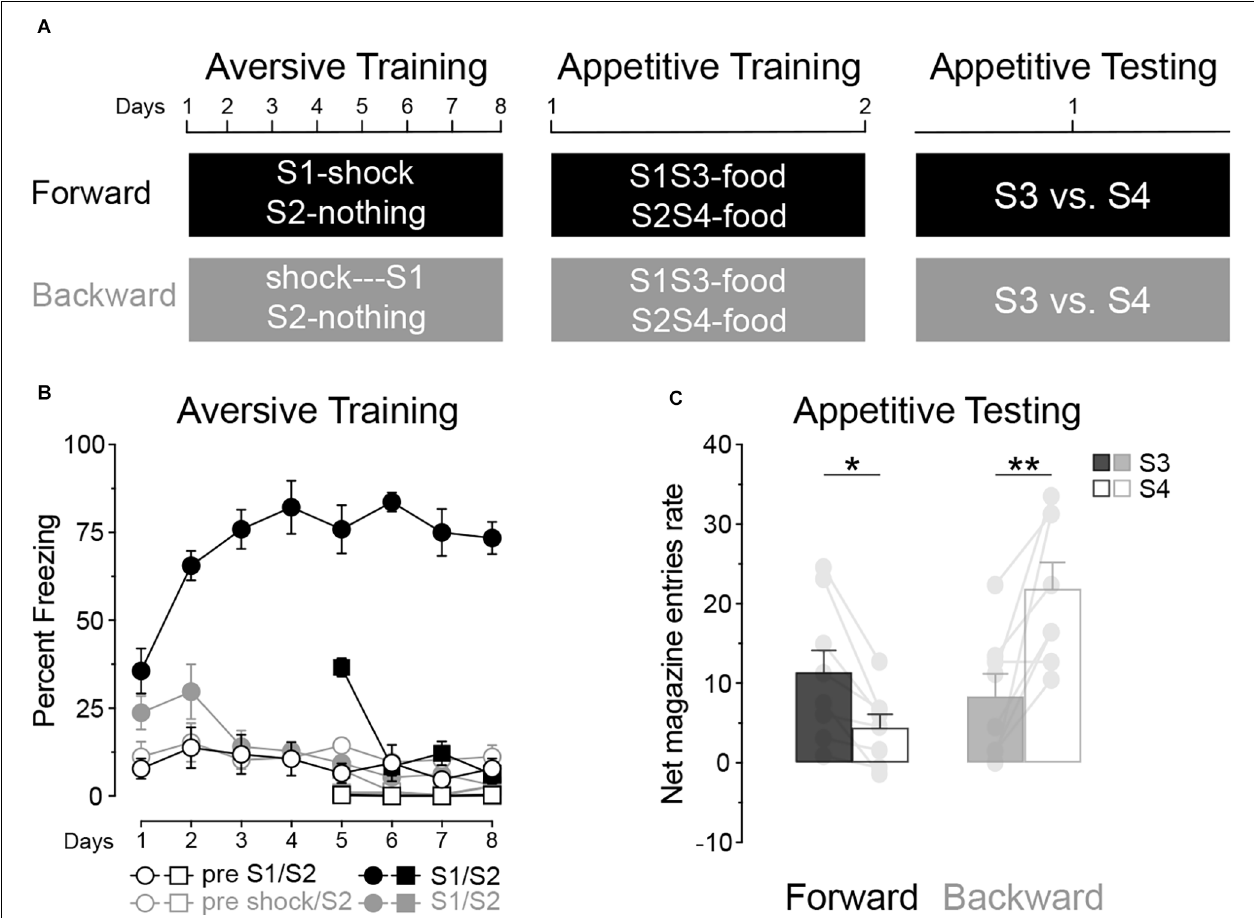
FIGURE 3 | An aversive excitor enhances, whereas an aversive inhibitor blocks, appetitive conditioning. (A) Design of Experiment 2; S1/S2/S3/S4: clicker, tone, flashing light or constant light (counterbalanced). (B) Aversive conditioning: S1 became an aversive excitor in group Forward and an aversive inhibitor in group Backward whereas S2 was neutral in both groups. (C) In group Forward, stimulus S3 elicited more appetitive responding than stimulus S4. The opposite was found in group Backward. Error bars denote ± 1 SEM. Asterisks denote significant effect (* p < 0.05; ** p <